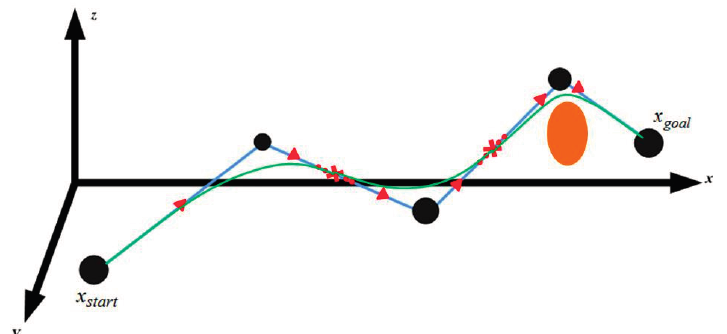
Figure 11. C 3 avoids the obstacle.